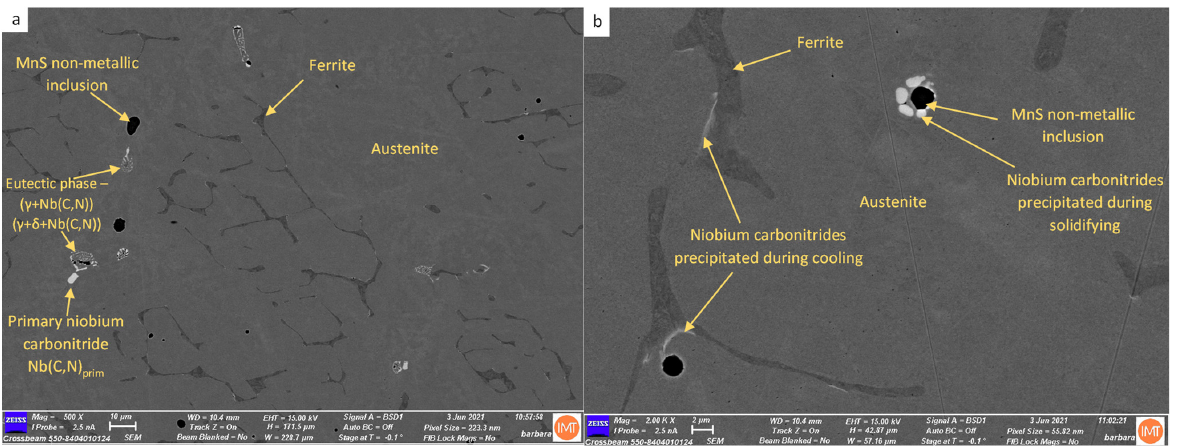
Figure 8. Backscattered electron images of the as-cast 10Ni-20 steel sample ( a ) lower magnification, ( b ) higher magnification.